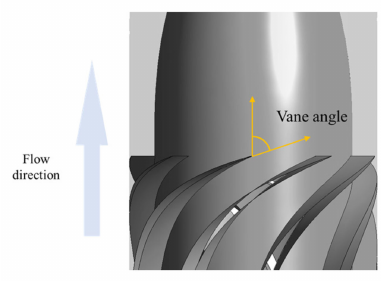
Figure 8. Schematic of the modeled vane